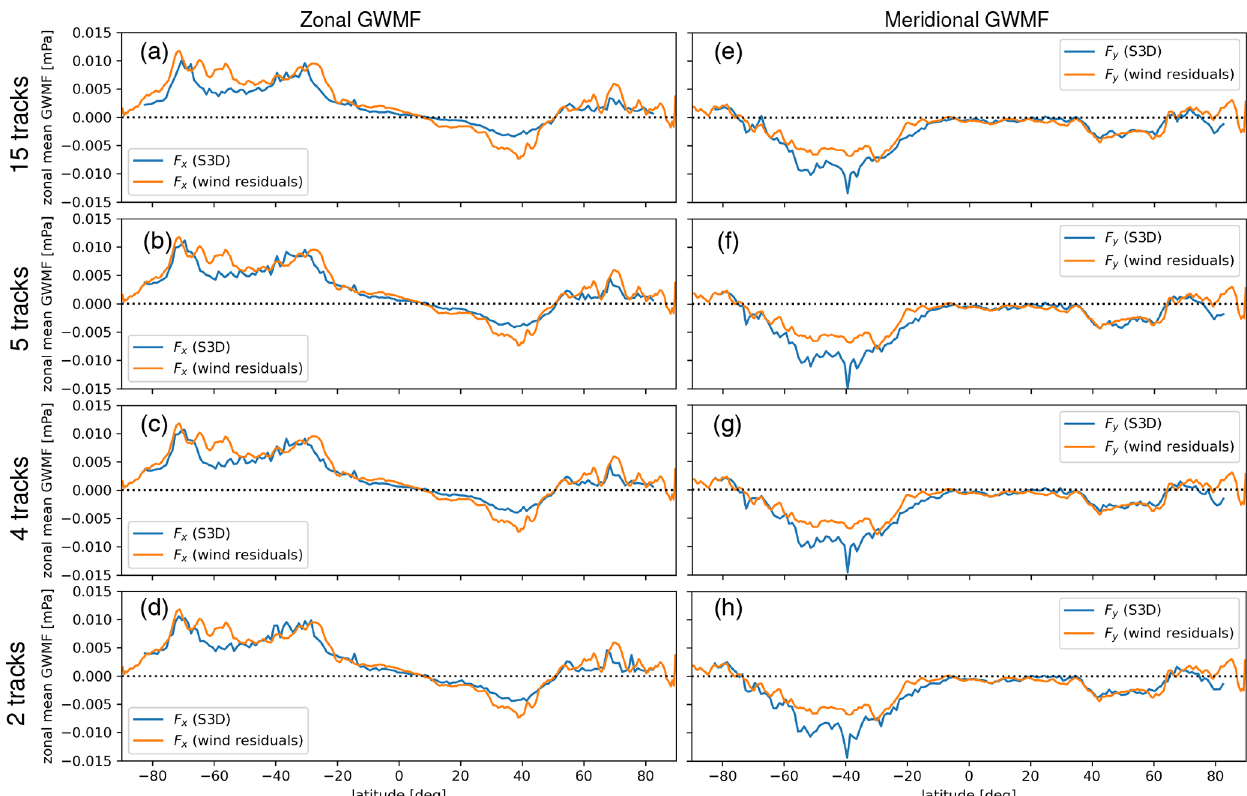
Figure 15. Same as for Fig. 14 but for an altitude of